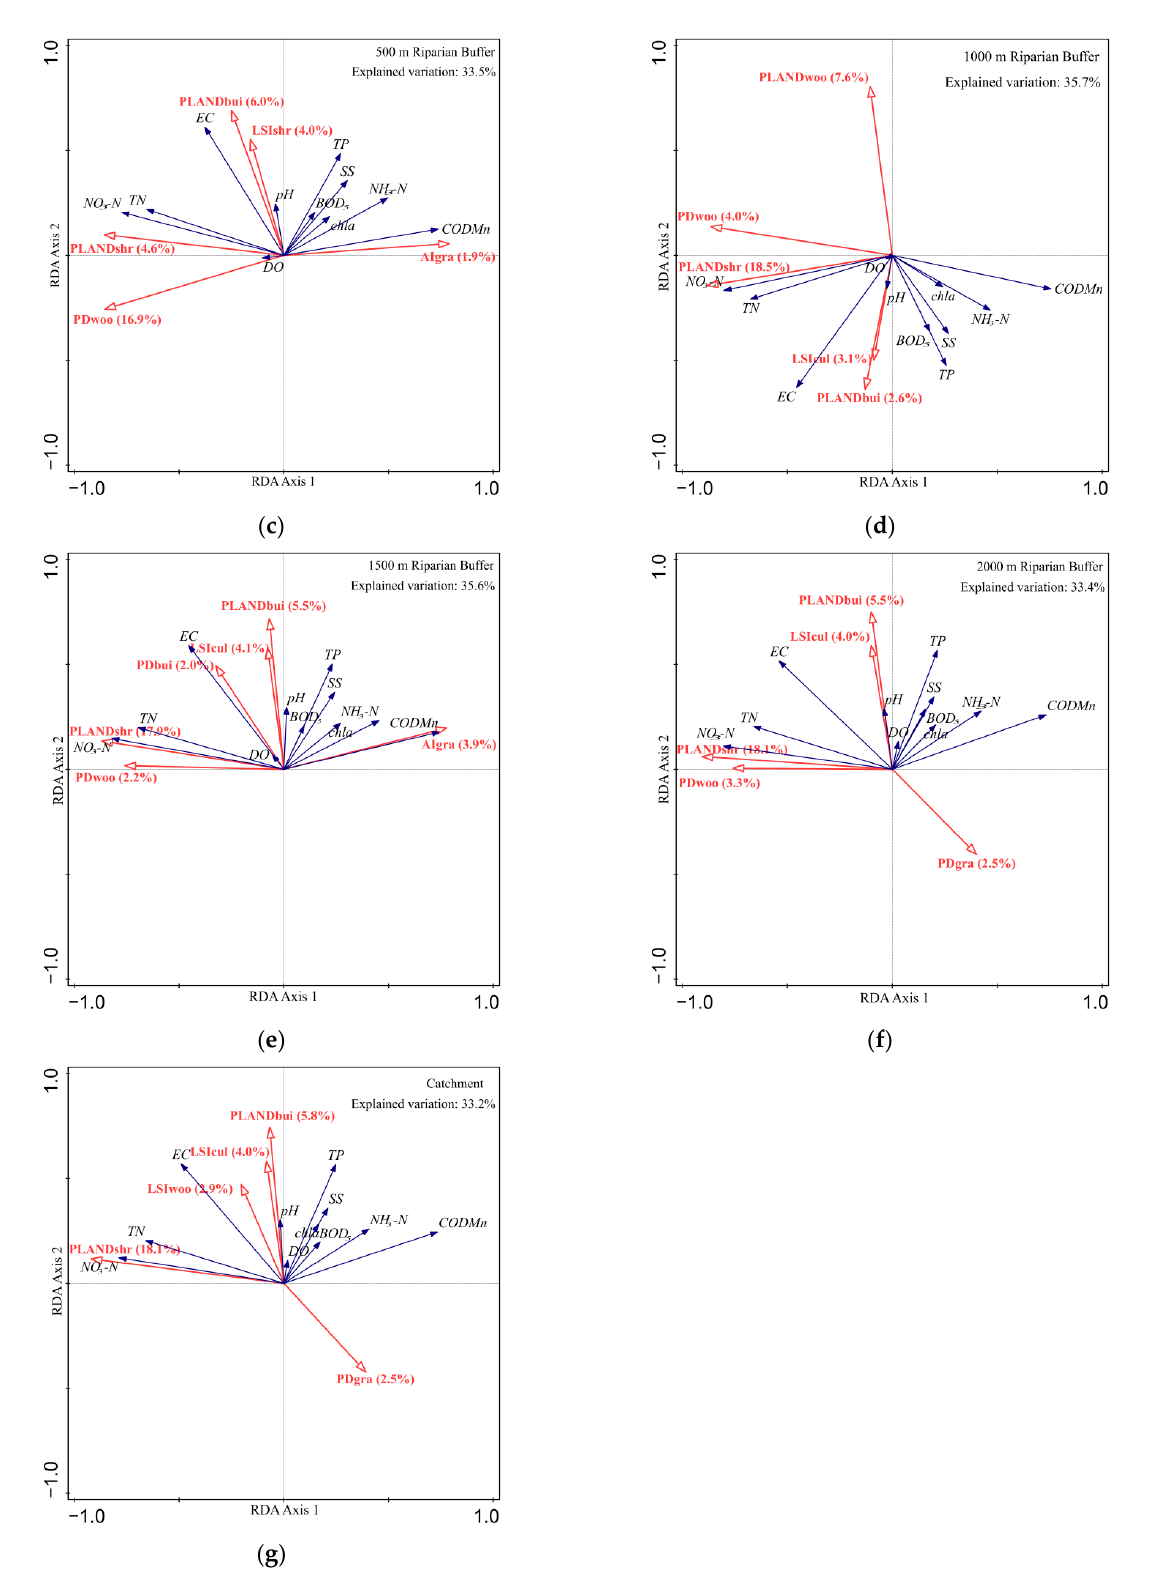
Figure 5. Redundancy analysis (RDA) biplots showing the correlation between water quality variables (black arrows) and land use variables (red arrows). ( a–f ) respectively represent the scale of a riparian buffer with different widths (100 m, 200 m, 500 m, 1000 m, 1500 m, and 2000 m), and ( g ) represents catchment scale.